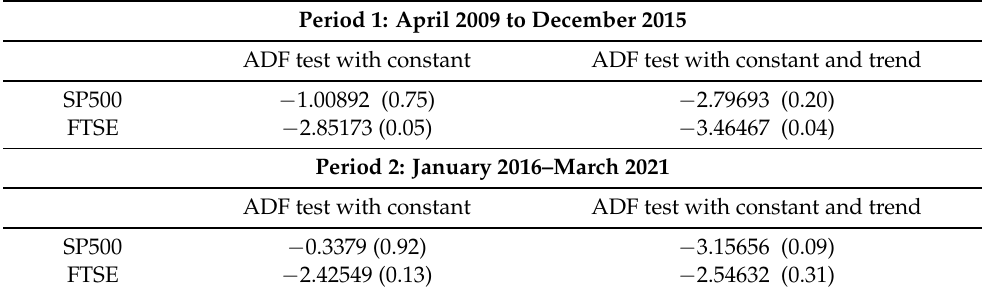
Table 2. Augmented Dickey–Fuller (ADF) Tests.